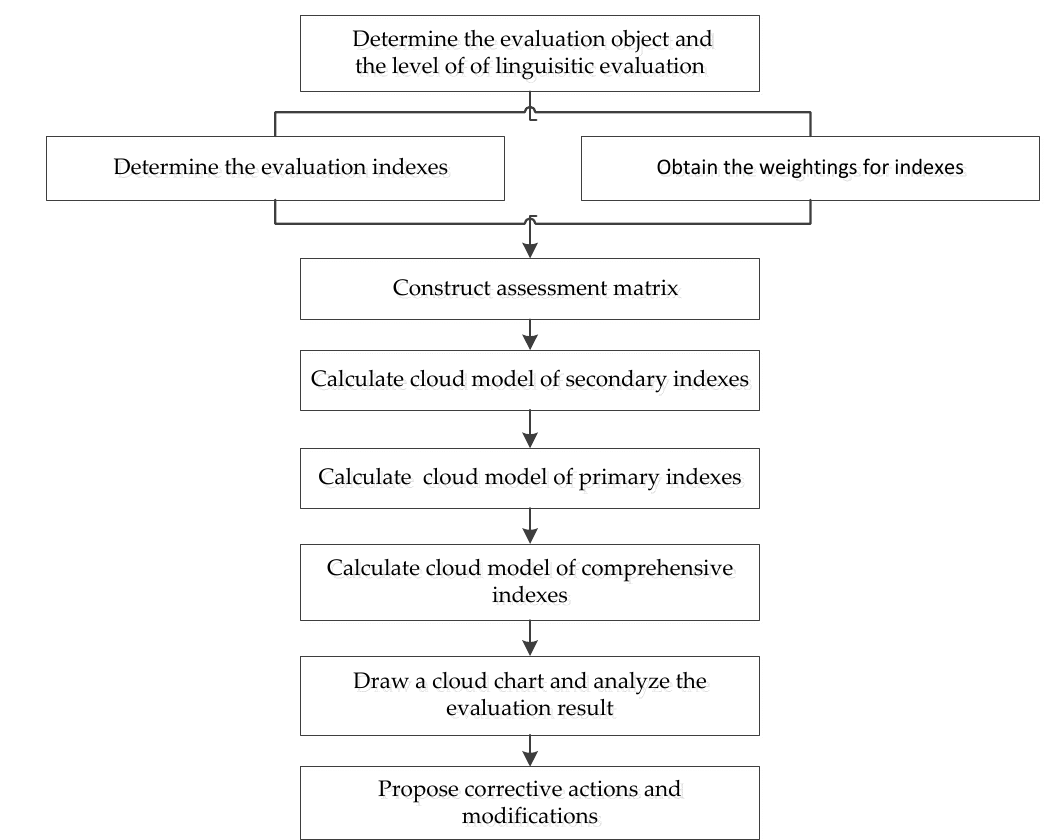
Figure 1. Flowchart of the proposed assessment method.